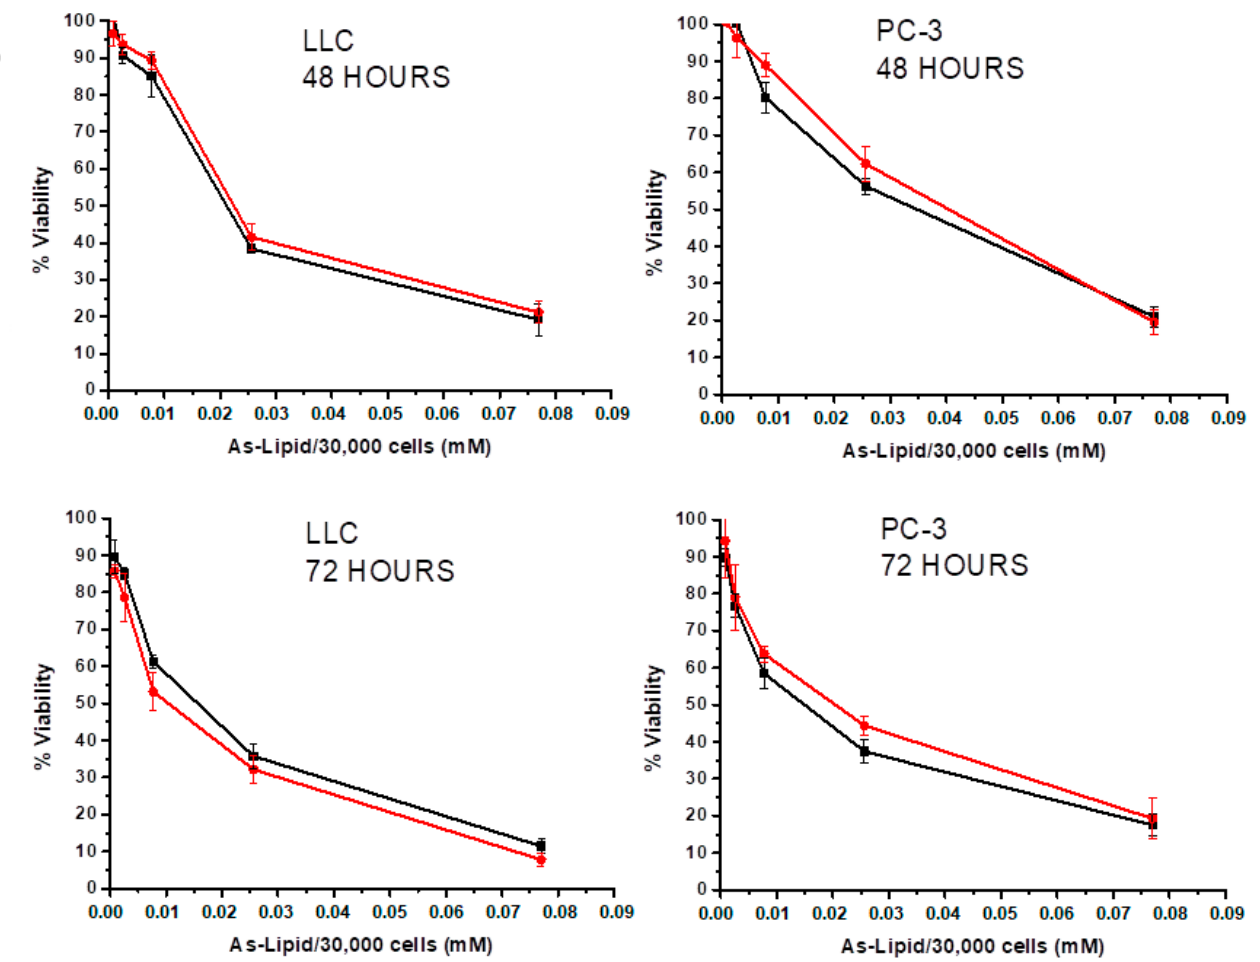
Figure 6. ( Α ) Viability of LLC and PC-3 cancer cells after incubation with As-liposomes for 24 h at high concentrations (up to 0.5 mM As-Lipid/30,000 cells); ( Β ) viability of LLC and PC-3 cancer cells after incubation with As-liposomes for 48 and 72 h at low concentrations (up to 0.08 mM As-Lipid/30,000 cells). The black line refers to the As-ester-lipid liposomes of type 2 , while the red line refers to the As-ether-lipid liposomes of type 5 .